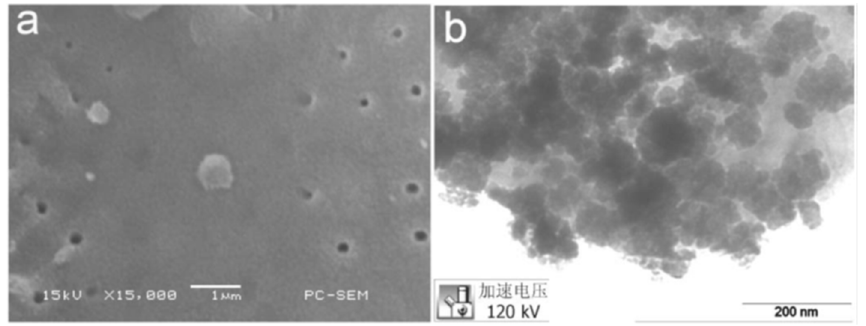
Figure 4 . SEM ( a ) and TEM ( b ) of 15CN2K/diatomite catalyst .